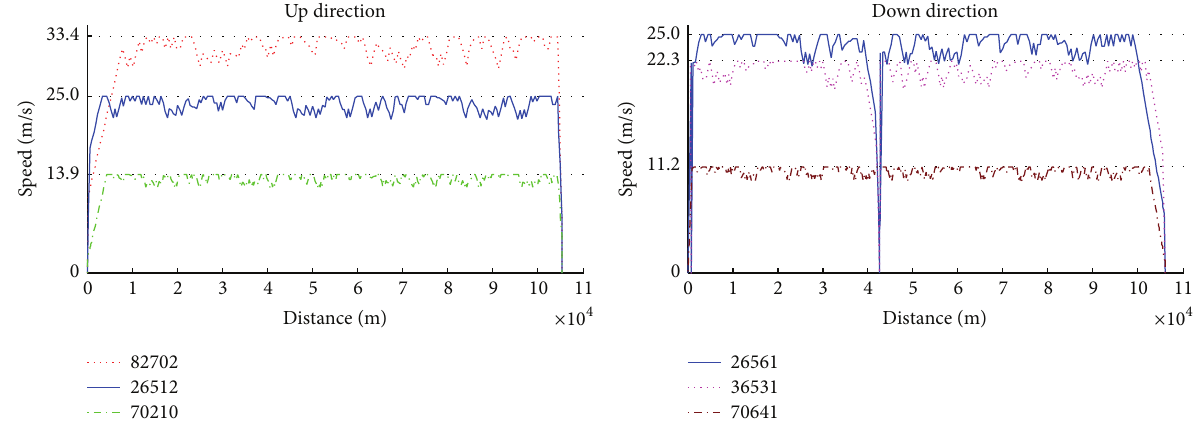
Figure 2: Train speed-distance curve (NCBS: blocking section 2 in the